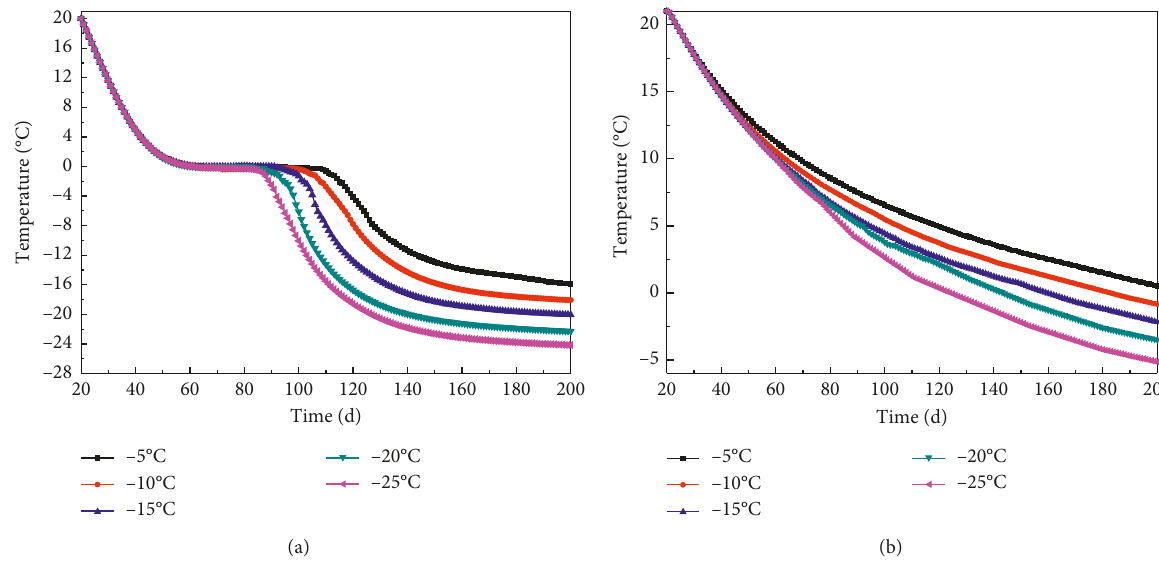
Figure 16: Temperature variation curve of measurement points in different regions under the action of the limited freezing section of different temperatures. (a) Temperature curve of the measurement point C2. (b) Temperature curve of the shaft lining.